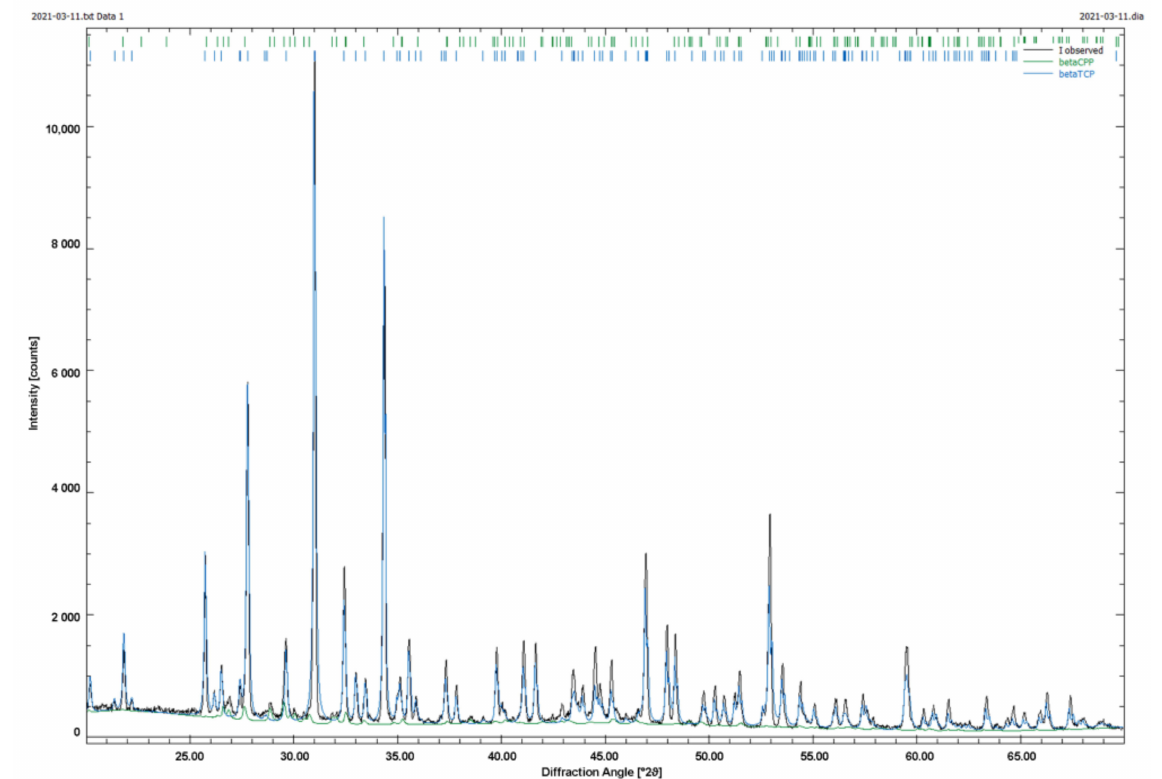
Figure 5. XRD Pattern of 3D printed samples, as example 1000(2000).